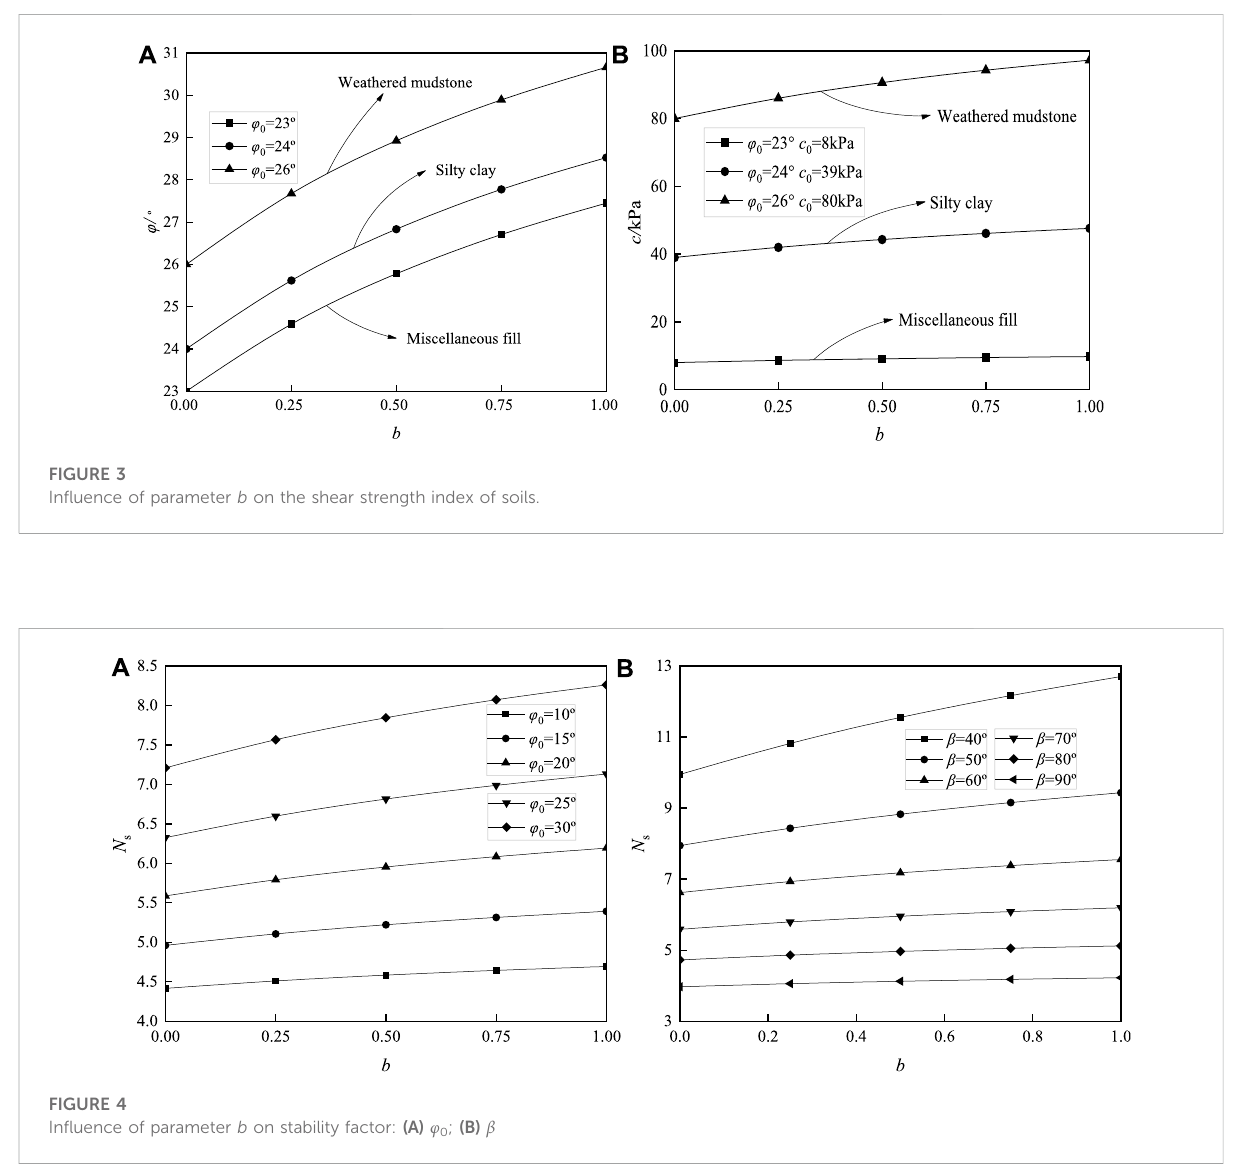
FIGURE 4 In fl uence of parameter b on stability factor: (A) φ 0 ; (B)